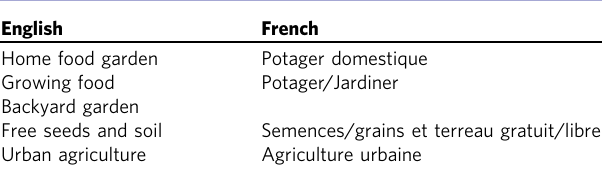
Table 2 Search terms used to discover municipal home food gardening programs.